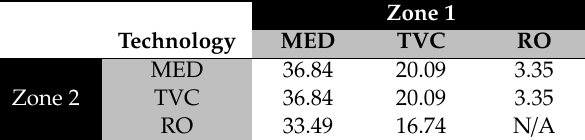
Table A4. Thermal energy price ( € / MWh).